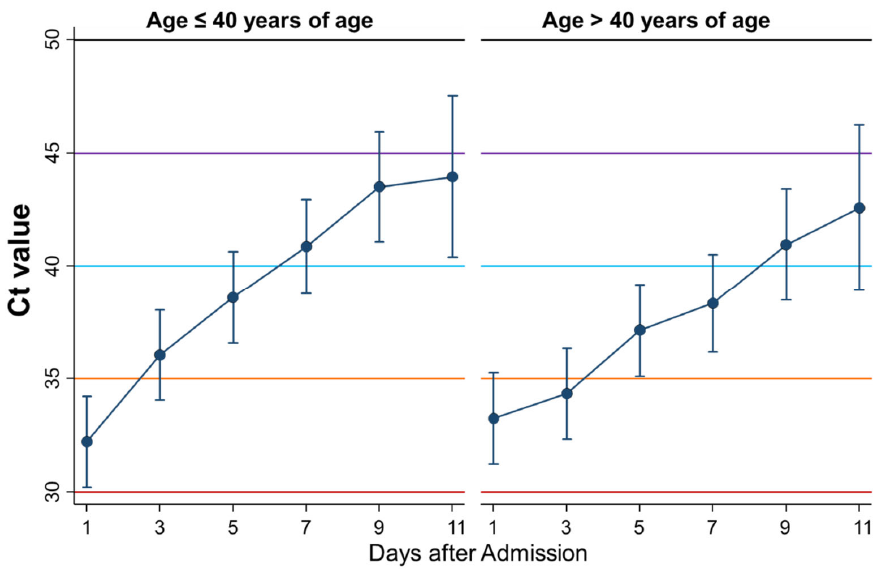
Figure 12. Differential kinetics of Ct values between age ≤ 40 y and >40 y. Mean Ct with 95% confidence intervals. When the Ct value is 40 or more, then the PCR test result is considered negative.